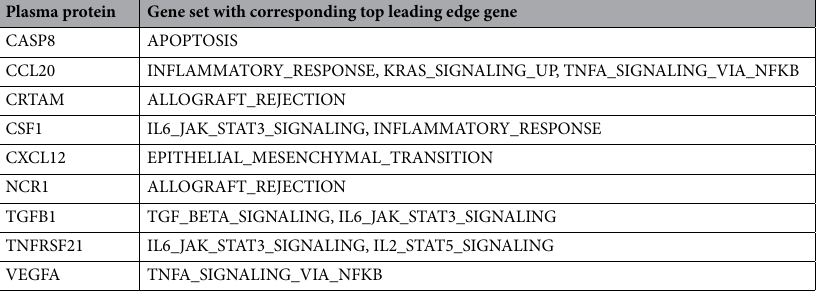
Table 1. Overlap of plasma proteins studied with top leading edge genes within differentially modulated gene sets. Abbreviations: CASP8, caspase 8; CCL20, C–C motif chemokine ligand 20; CRTAM, cytotoxic and